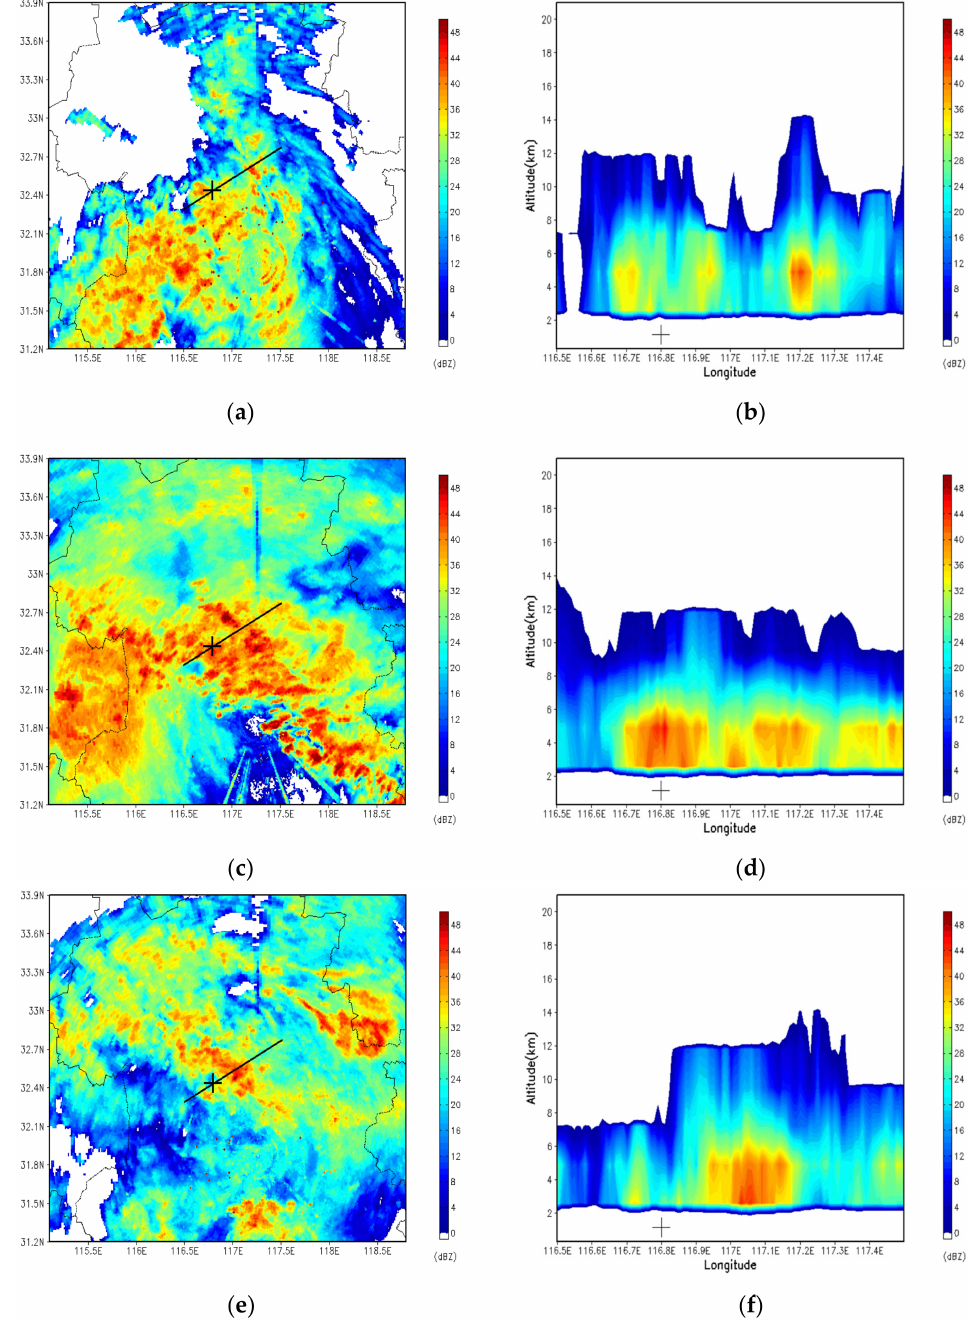
Figure 4. Reflectivity of the S-band Doppler weather radar (the black cross symbol represents the location of the C-FMCW radar and the MRR). ( a ) Composite reflectivity at 1706 LST on 22 June; ( b ) vertical cross section along black line in figure ( a ); ( c ) composite reflectivity at 0336 LST on 28 June; ( d ) vertical cross section along black line in figure ( c ); ( e ) Composite reflectivity at 1506 LST 11 July; ( f ) vertical cross section along black line in figure ( e